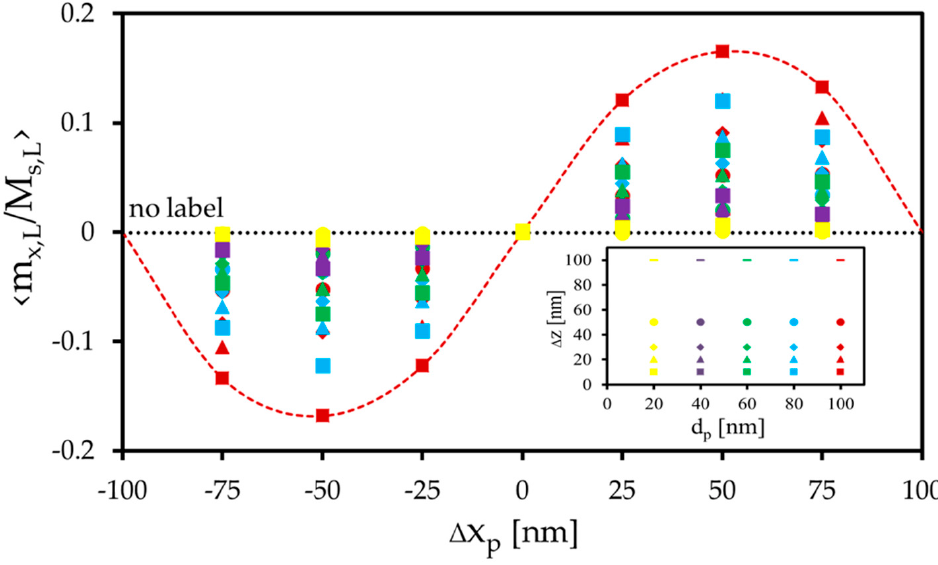
Figure 7. Change in averaged x-magnetization due to the x-shift in the magnetized label. The y-shift in the label leads to an equal distribution of the averaged y-magnetization. The inset shows the label diameters d p and heights ∆ z used for the simulation.